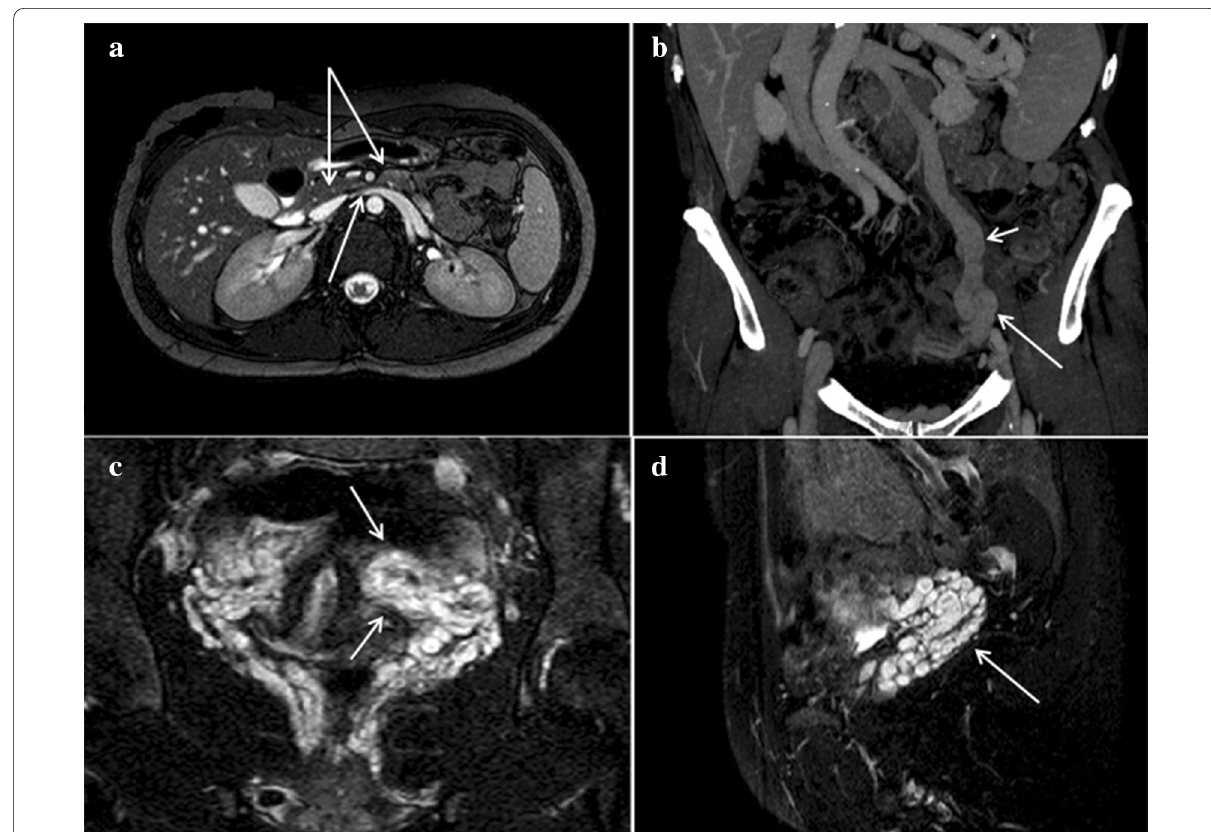
Fig. 9 Abdomen MRI examination. a The axial plane reconstruction shows a stenosis of the left renal vein and duodenum (arrows) in the aorto-mesenteric angle (arrow). b The coronal plane reconstruction shows gonadal vein (short arrow) and gonadal plexus (long arrow) dilatation. c The coronal plane reconstruction shows the varicosities of the gonadal plexus (arrow), also evident in the reconstruction according to a sagittal plane